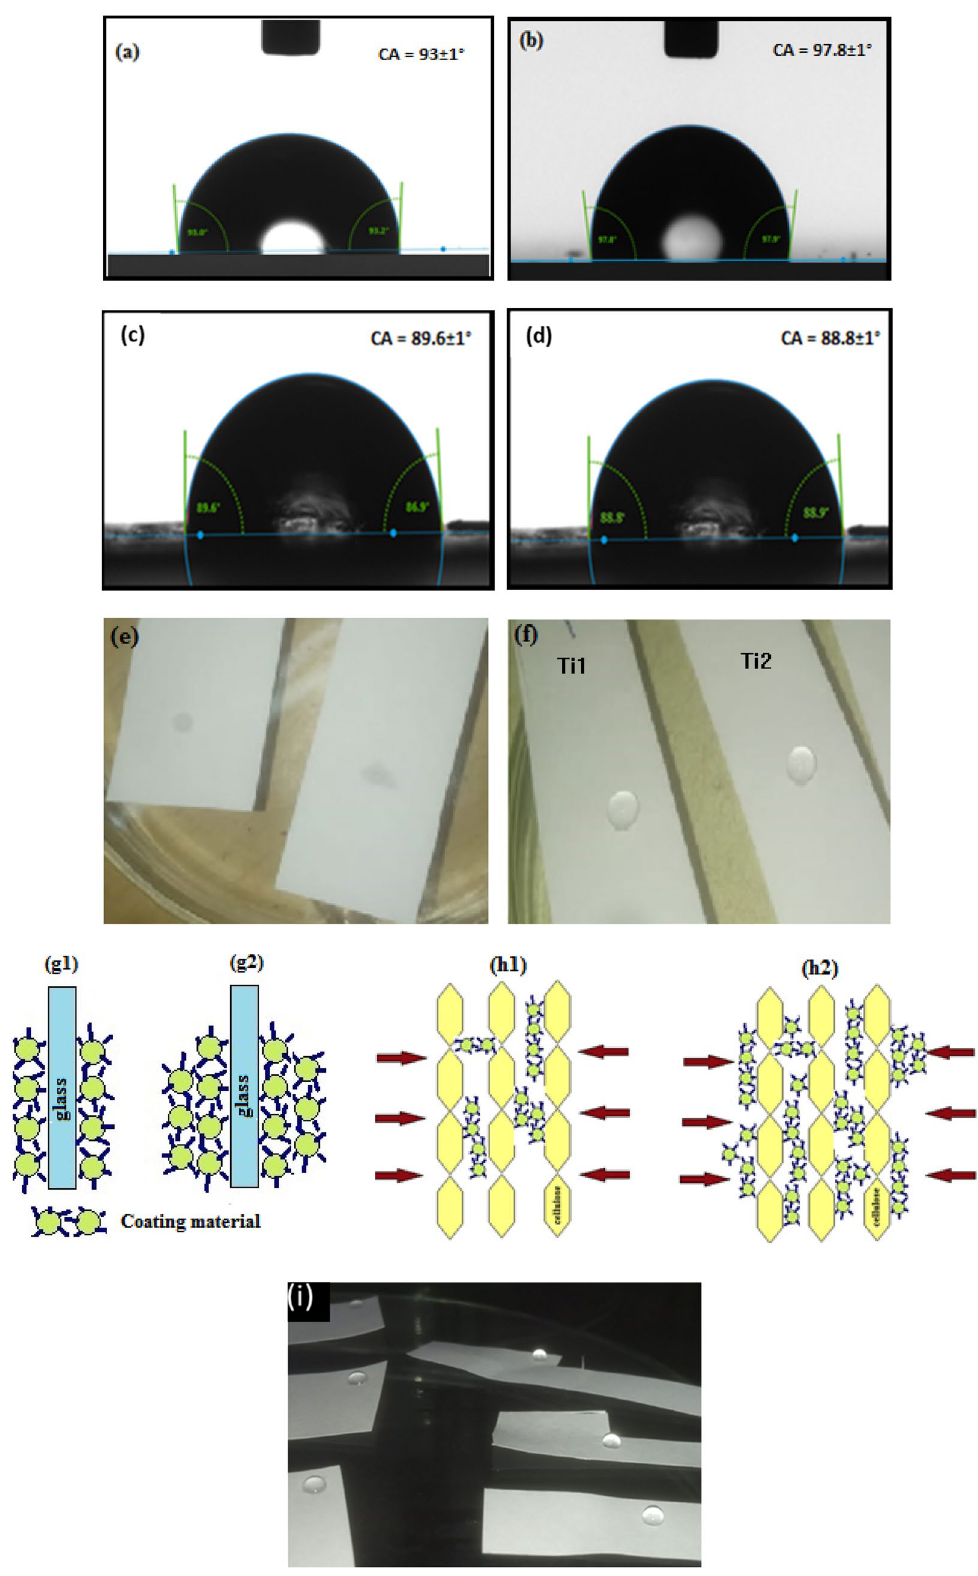
Figure 3. ( a , b ) Contact angle on Ts1 and Ts2 dip coated samples; ( c , d ) Contact angle on Ti1 and Ti2 dip coated samples (Contact angle goniometer (DATA Physics OCA 15 EC); ( e ) water droplet getting absorbed on uncoated paper; ( f ) water droplet on Ti1 and Ti2 single dip coated paper ; ( g1 , g2 ) hydrophobic coating on surface of glass or metals; ( h1 , h2 ) hydrophobic coating on cellulosic paper; ( i ) water droplets on single and multiple dip coated paper samples in